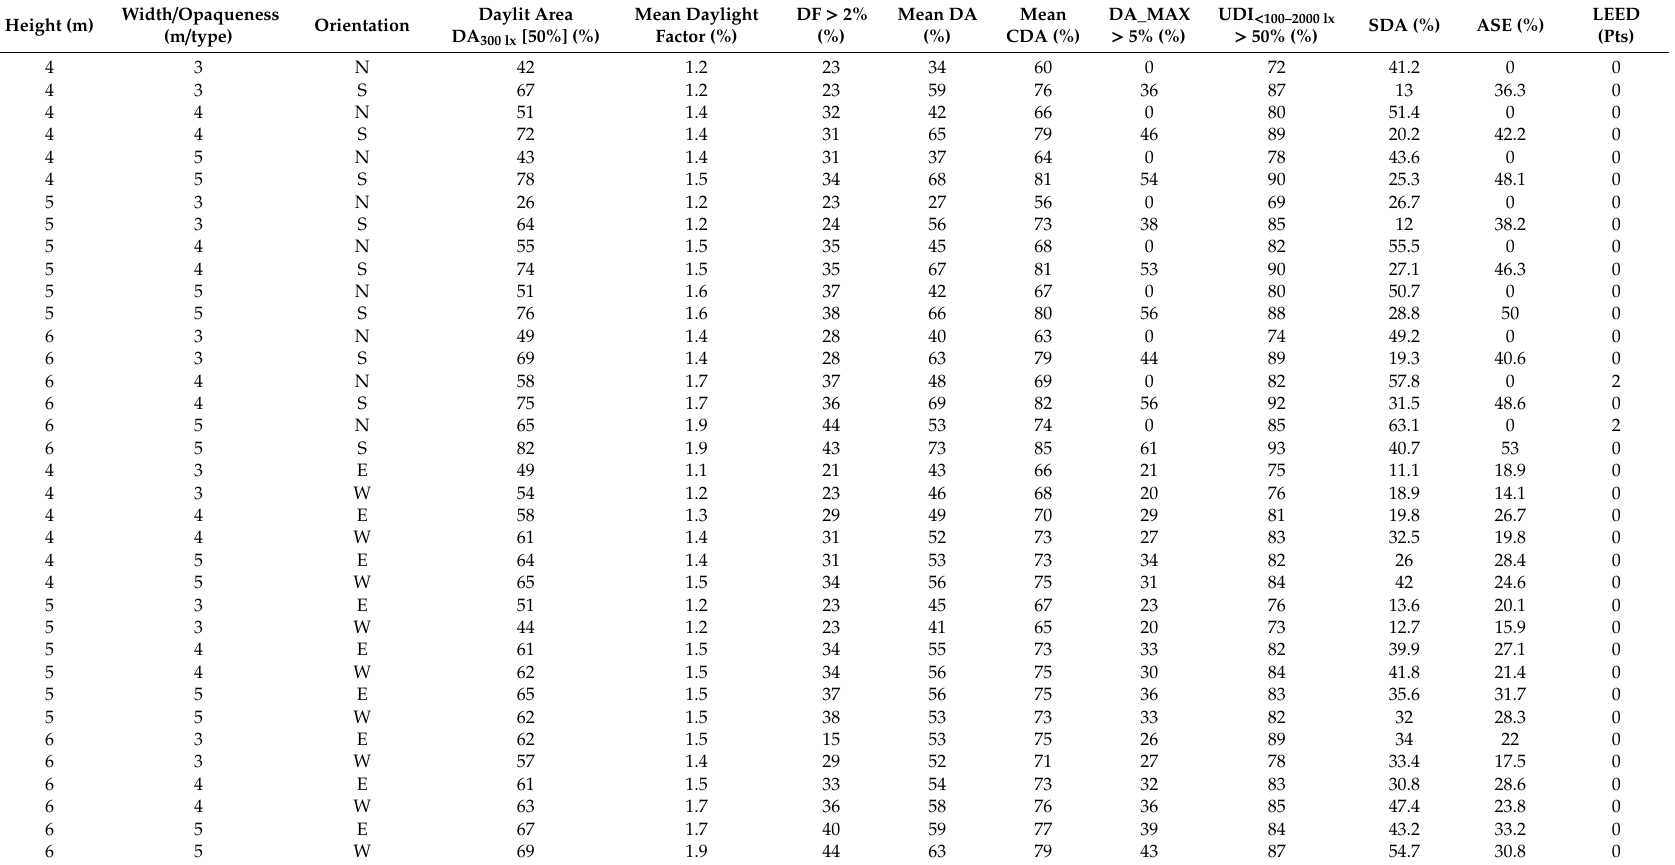
Table 7. Daylight Simulation Results for saw tooth